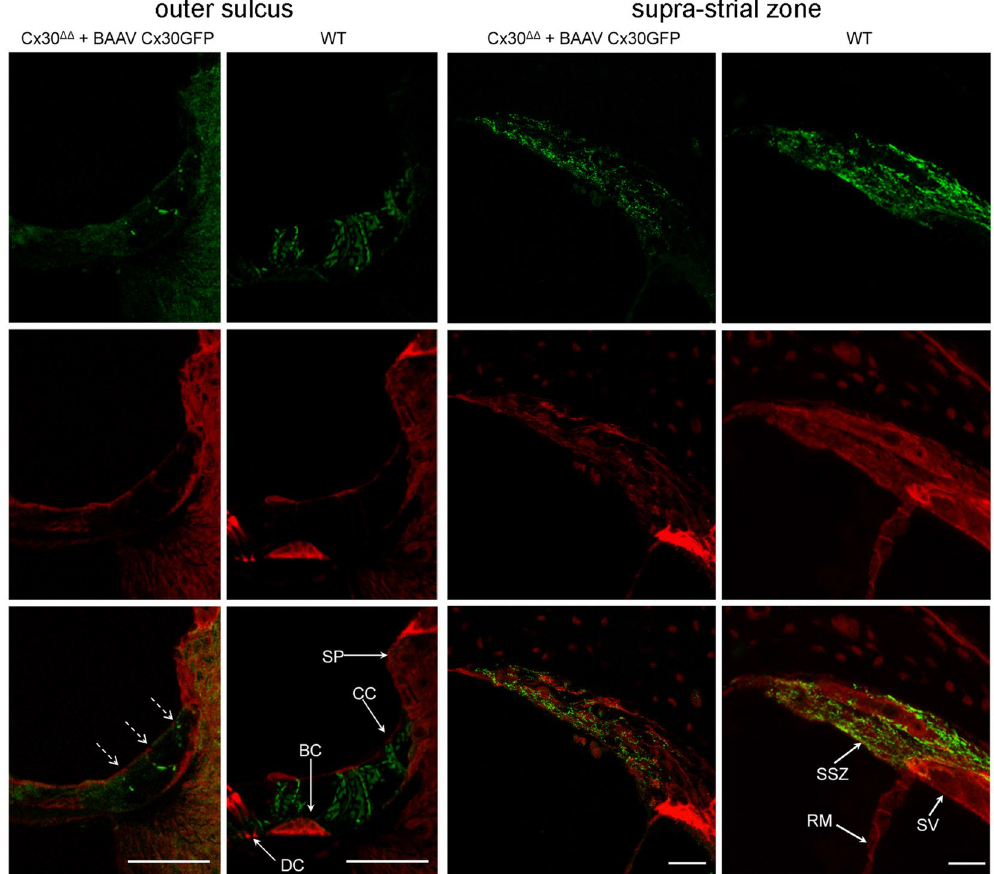
Figure 7. Cx30 expression in cochlear outer sulcus and supra-strial zone of Cx30 Δ / Δ mice four weeks after delivery of BAAVCx30GFP viral vector at P4. Shown are midmodiolar sections from injected Cx30 Δ / Δ mice (Cx30 Δ / Δ + BAAVCx30GFP) and non-injected wild type (WT) age-matched controls. Dashed arrows indicate gap junction plaques formed by recombinant Cx30GFP. The green signal was generated by immunostaining against GFP (Cx30 Δ / Δ+ BAAVCx30GFP) and native Cx30 (WT), respectively. red, actin filaments; blue, nuclei. BC: Böttcher cells; CC: Claudius’ cells; DC: Deiters’ cells; RM: Reissners’ membrane; SP: spiral prominence; SSZ: supra-strial zone; SV: stria vascularis. Scale bars: 50 μ